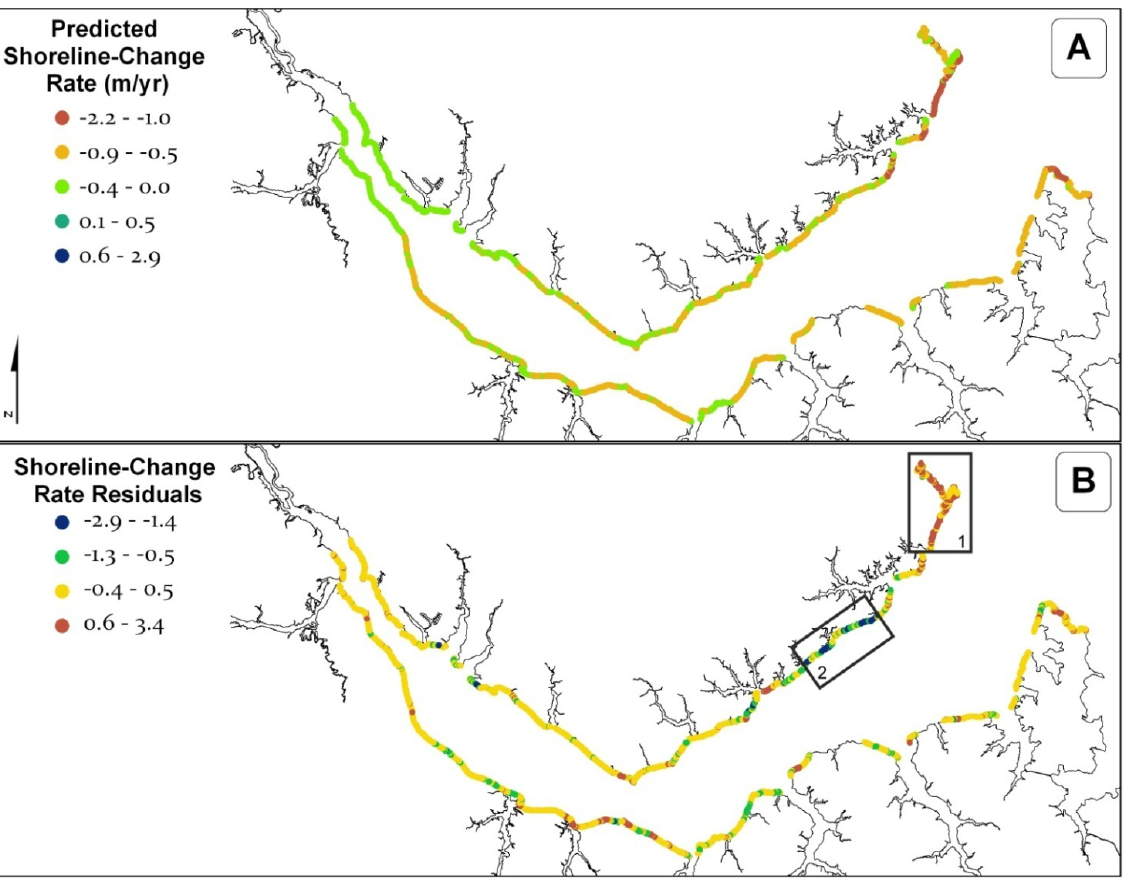
Figure 7. Maps displaying (A) the predicted shoreline-change rate values using the linear regression equation of Mean Fetch versus SCR (see Figure 6(C)) and (B) the